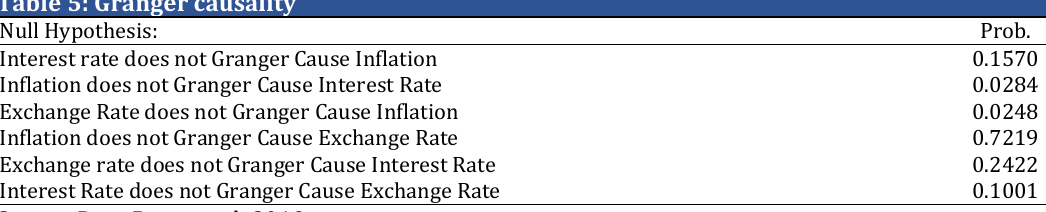
Table 5: Granger